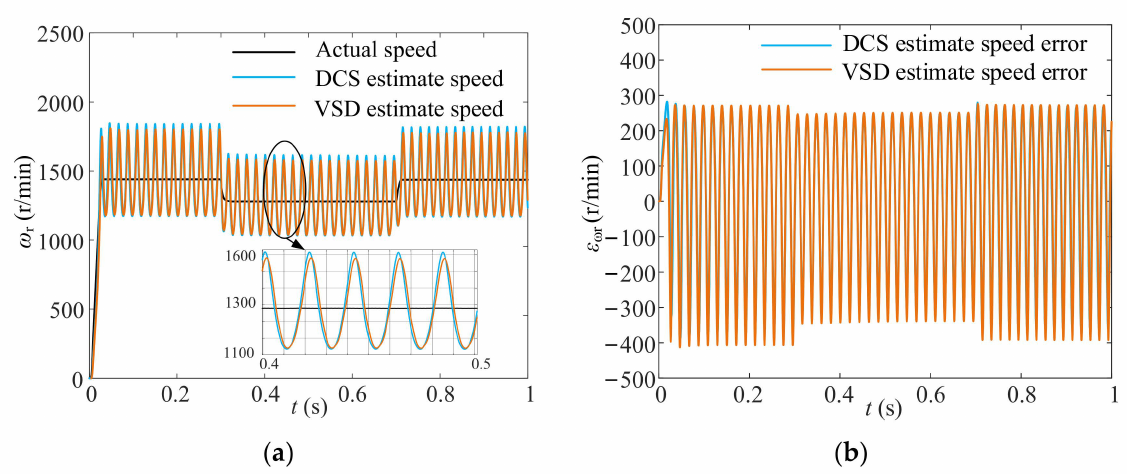
Figure 13. Speed-estimation results without stator resistance identification under dynamic conditions. ( a ) Speed; ( b ) Speed errors.